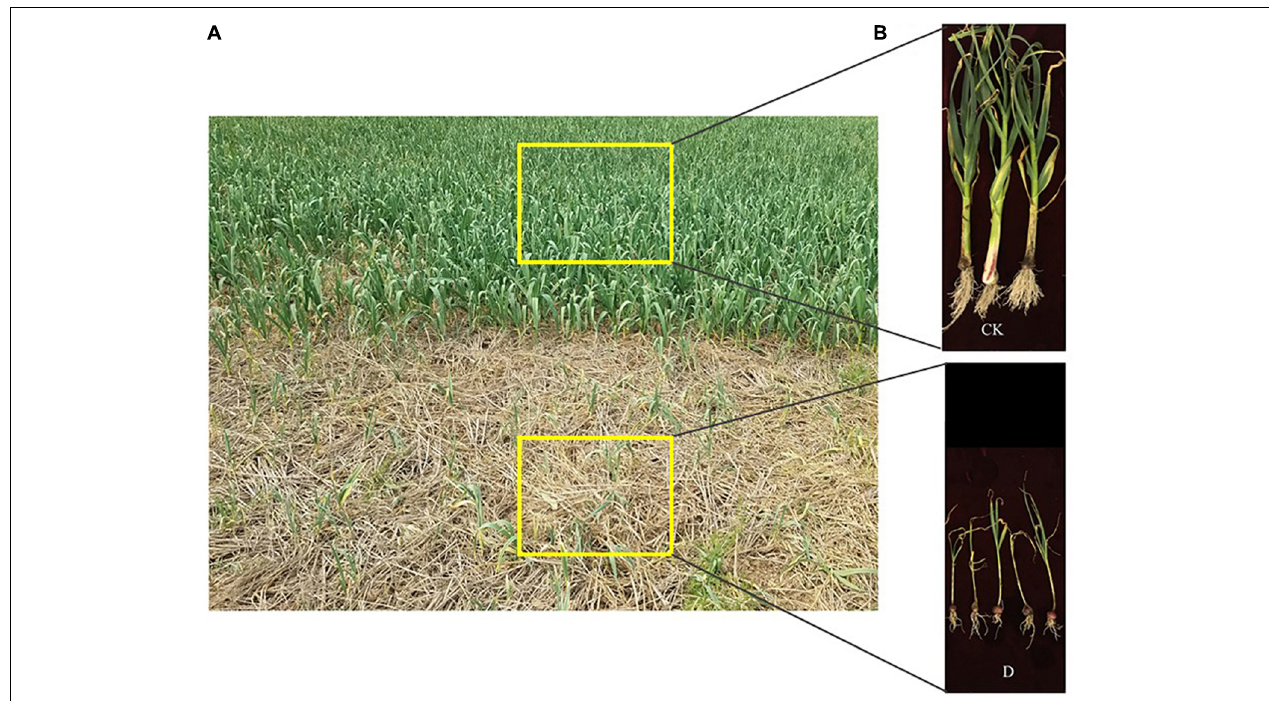
FIGURE 1 | (A) A garlic field with cropping obstacle (foreground) and healthy garlic plants (background). (B) Garlic plants grown in the healthy control soil (CK) and in the cropping obstacle soil (D).